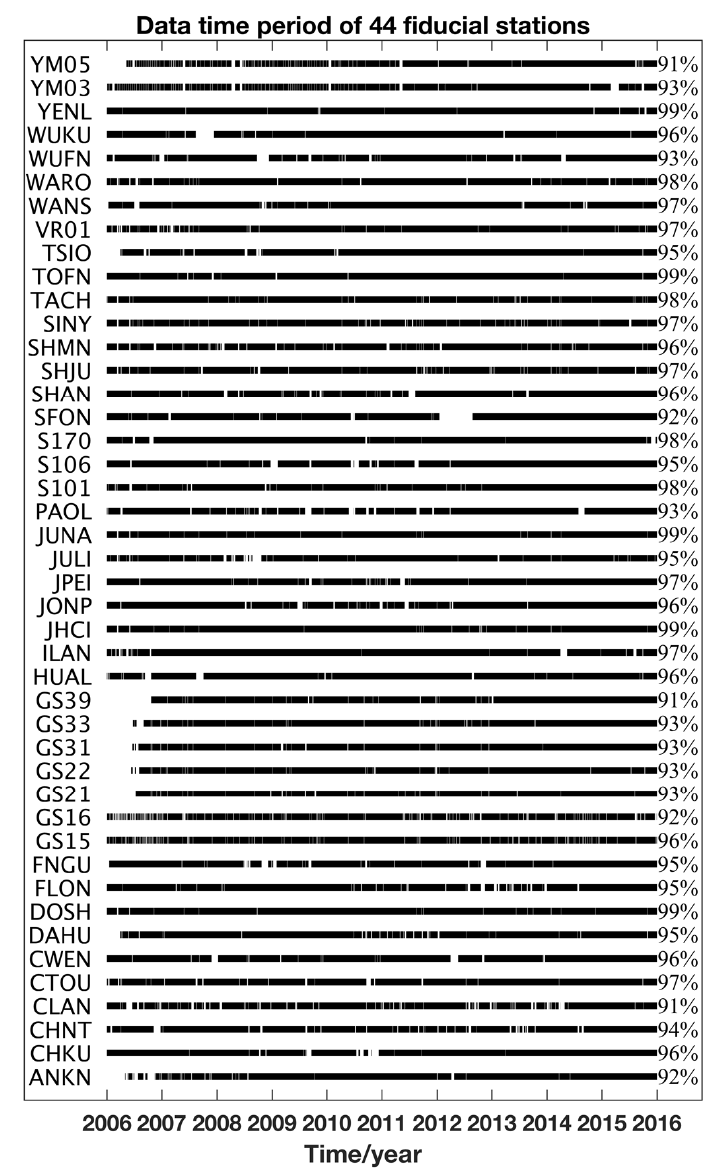
Figure 2. Data availability of the 44 GPS sites. Blanks represent the missing data. In the data pre-processing of the 44 GNSS stations, we used Equation (2) to fit the time series of each station, and eliminated the linear term and offset term, to smoothen the observation, and input the missing data. The time series after unified treatment ranges from approximately − 20 to 20 mm. We selected five stations with a notable linear term, offset term and missing data in the coordinate time series (CHKU, JUNA, S101, SFON and SHAN), as indicated on the left in Figure 3, and the pre-processed data are presented on the right. It can be seen that the linear term, offset term, and missing data are all